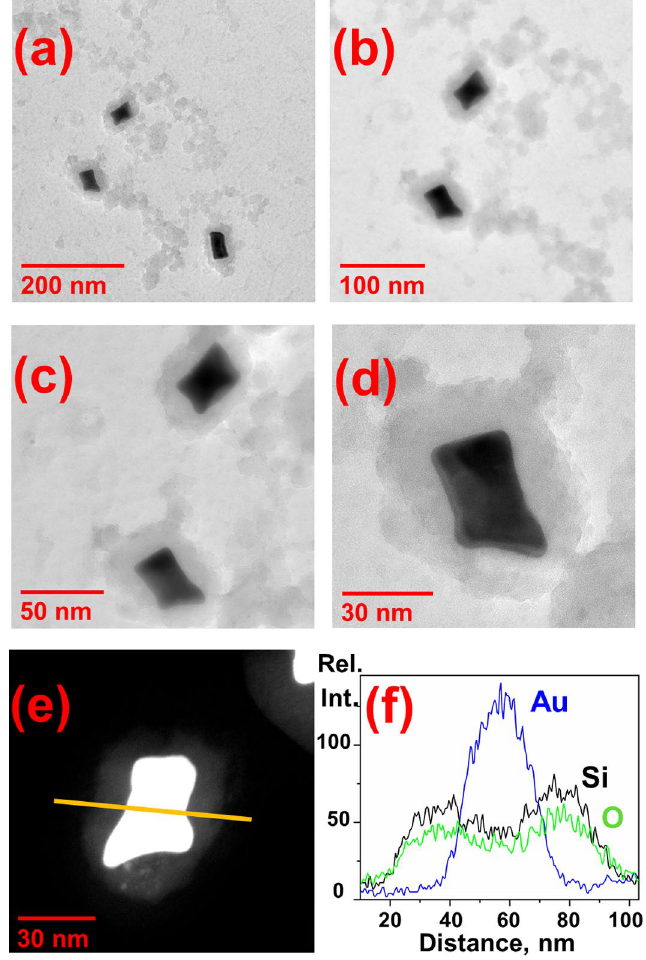
Figure 3. ( a – d ) TEM images of gold nanoparticles coated with silica using MPTMS. ( e ) STEM image of nanotag with an arrow indicating the EDX line scan position. ( f ) EDX line scan for Si K α , O K α , and Au L α signals of the particle shown in ( e ).